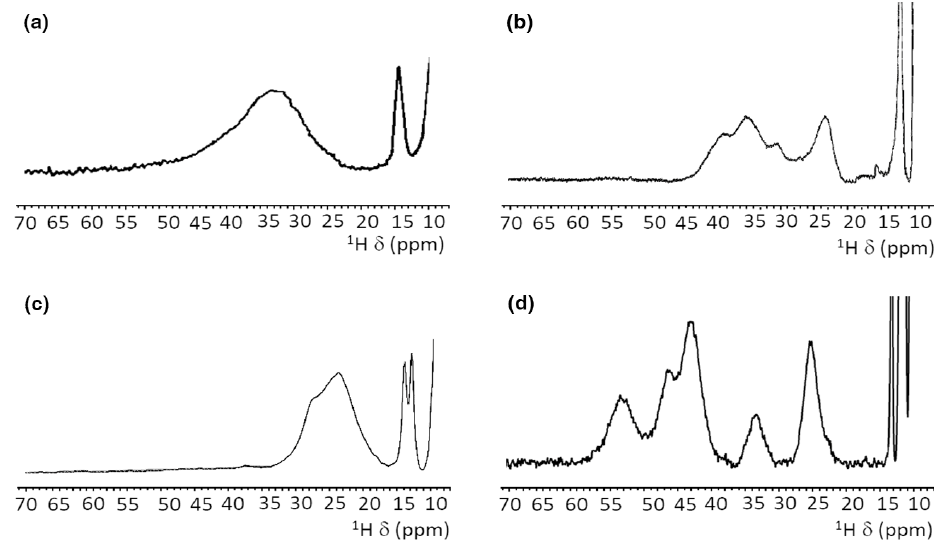
Figure 4. Paramagnetic 1 H NMR spectra of [ Fe 2 S 2 ] 2 + -containing proteins: (a) ferredoxin from red algae (Banci et al., 1990b); (b) human ISCA2 (Brancaccio et al., 2014); (c) human Glutaredoxin-5 (Banci et al., 2014); (d)